Question: Give a one-sentence summary of this figure.
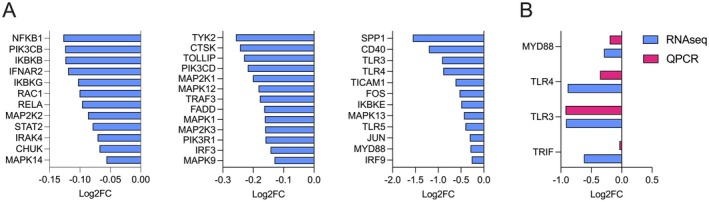
Answer: TLR pathway genes whole transcriptome sequence and qPCR. (A) Log 2 fold change gene expression levels of main genes in the TLR signalling pathway. (B) Gene expression confirmation by qPCR vs. whole transcriptome sequence. MYD88, MYD88 innate immune signal transduction adaptor; TLR3, toll‐like receptor 3; TLR4, toll‐like receptor 4; TRIF or TICAM1, TIR domain containing adaptor molecule 1.